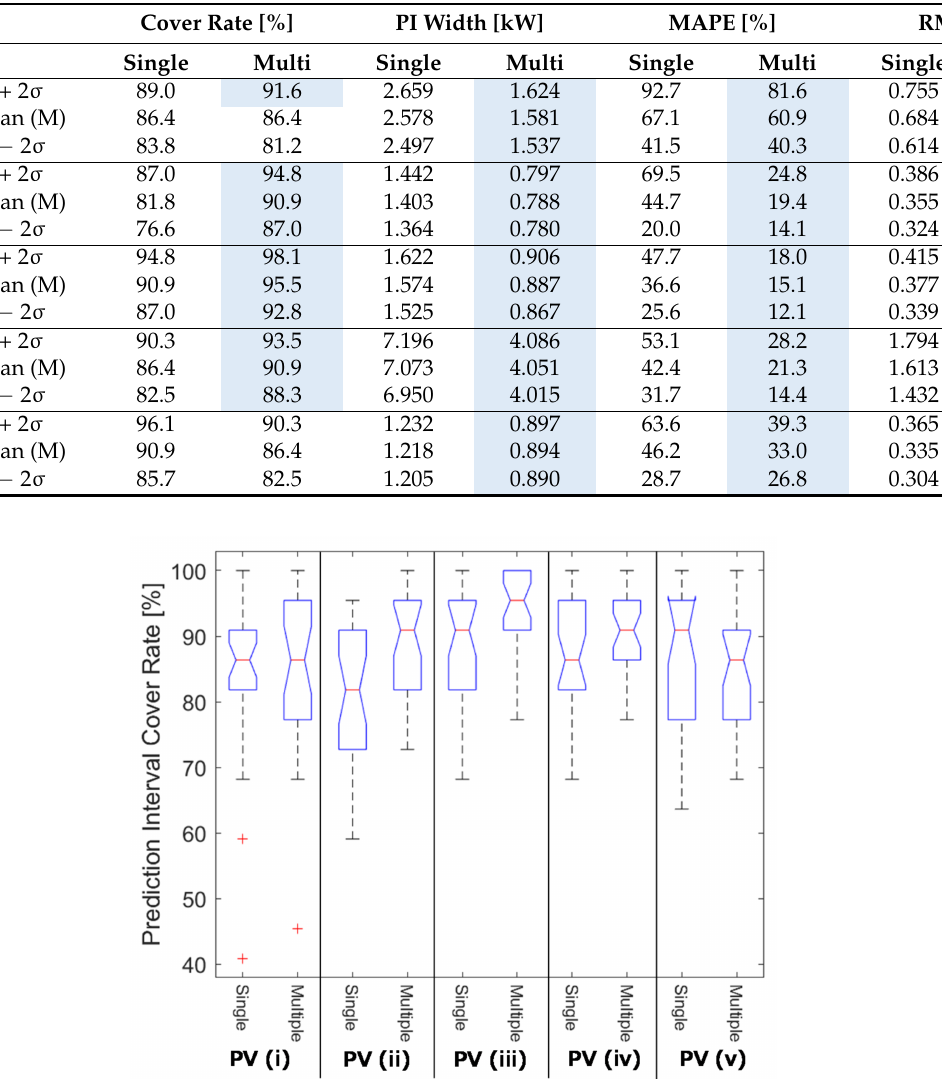
Figure 11. Box plot for prediction interval cover rate; Single PV vs. Multiple PV forecast model at five